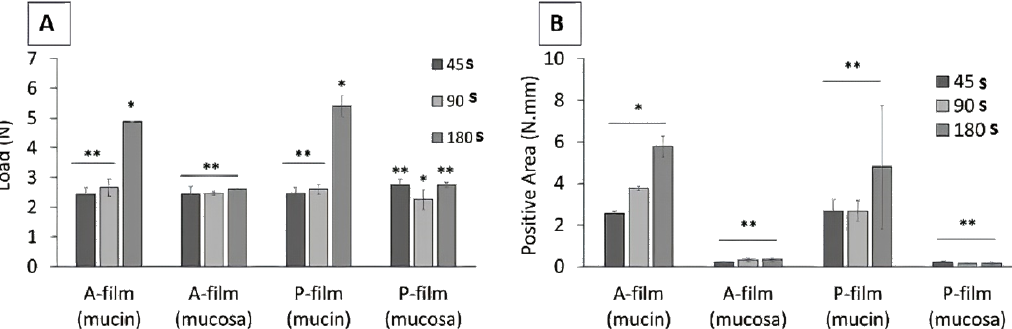
Figure 3. Mucoadhesive properties of mucoadhesive films. The maximum force of detachment ( A ) and the work of adhesion ( B ). * Means that statistical differences were found in different contact times ( p < 0.05). ** Means that statistical equals were not found in different contact times ( p > 0.05). ( n = 3; bar charts represent standard deviation values).